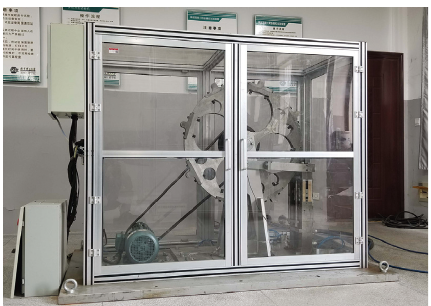
Figure 1: Prototype of the multiple impact equipment.